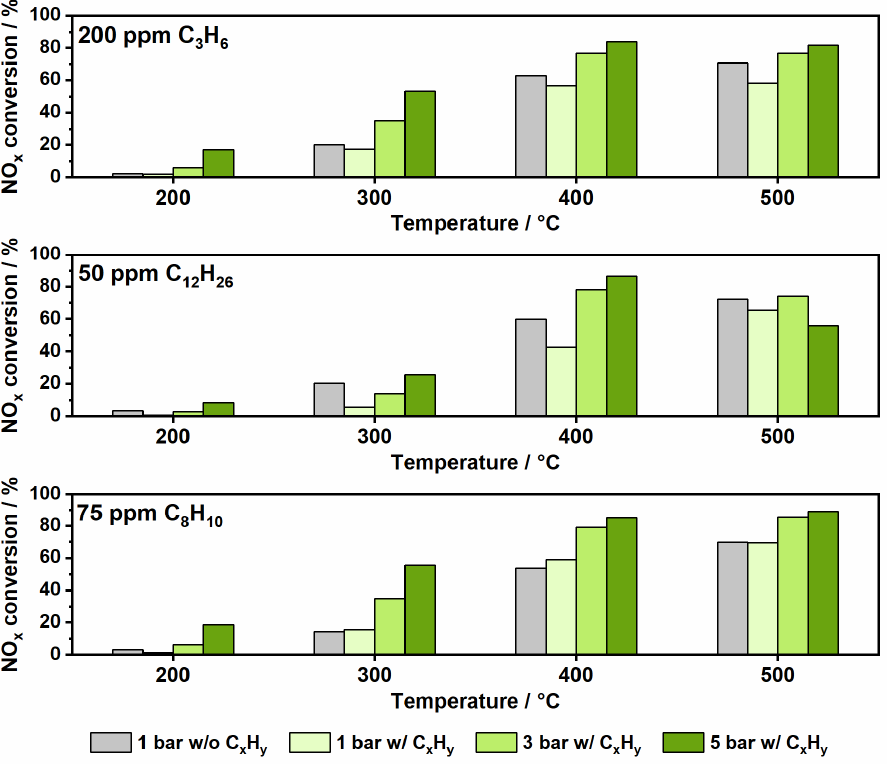
Figure 5. Comparison of NO x conversion at conventional conditions (1 bar in absence of hydrocar- bons) and under pre-turbocharger conditions (1, 3 and 5 bar in presence of hydrocarbons) over a Fe-ZSM-5 in a standard SCR gas mixture.